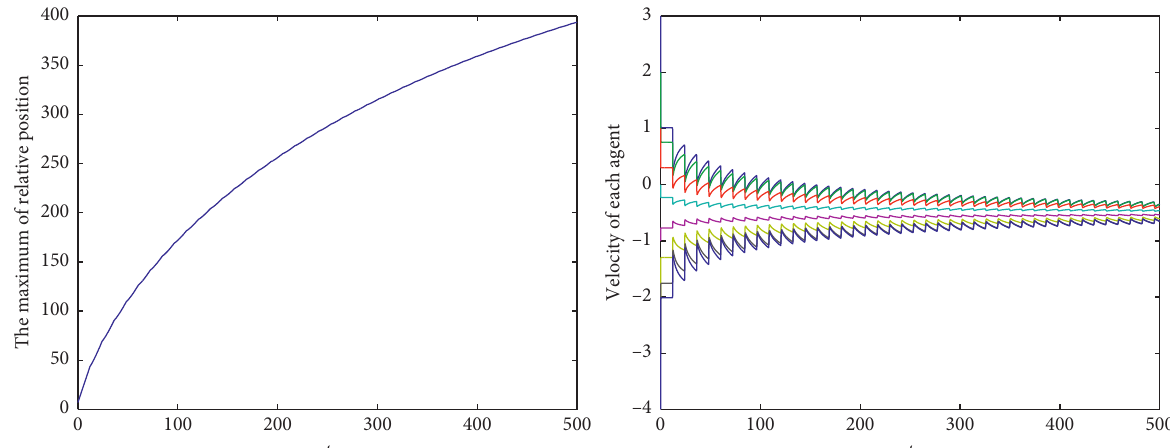
Figure 3: α � 15 , β � 0 . 51 , τ � 12 > τ . Systems (3) and (4) fail to the emergence of flocking due to the destruction of (22) in Theorem 2. 0